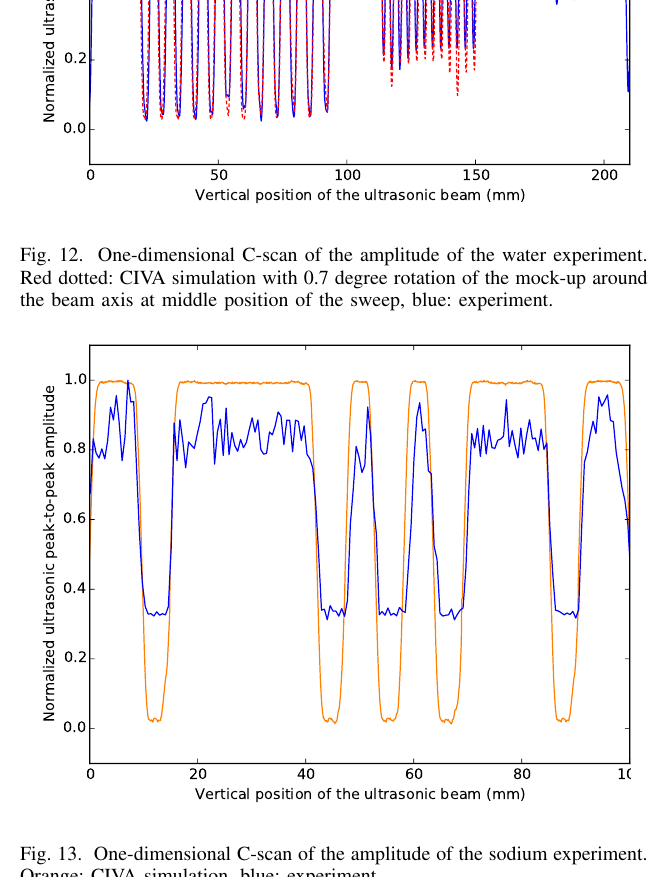
high temperature transducer, the TUSHT ® . The resulting